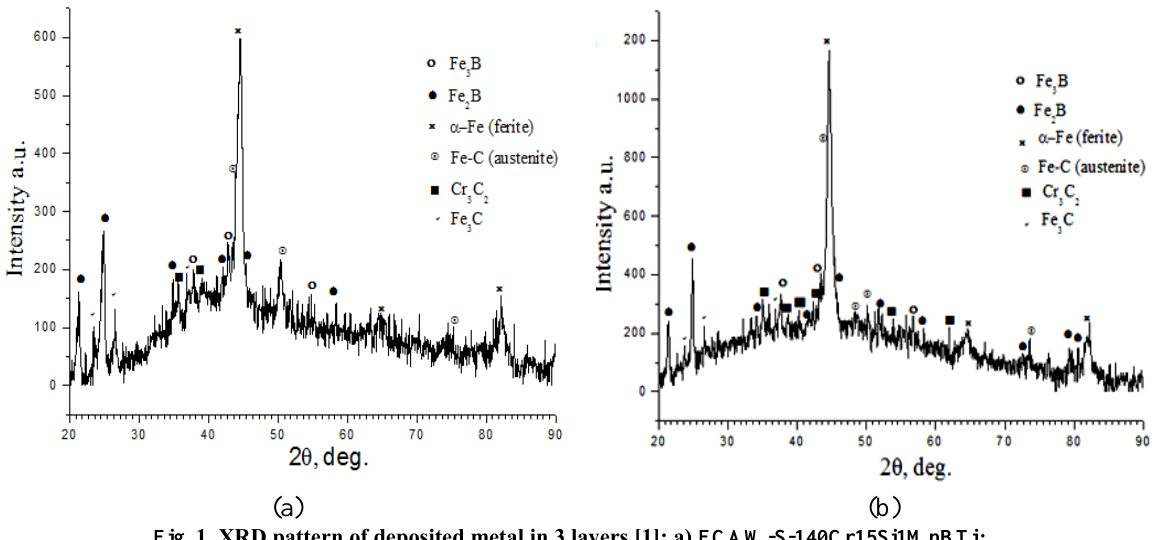
Fig. 1. XRD pattern of deposited metal in 3 layers [1]: а) FCAW-S-140Cr15Si1MnBTi; b) FCAW-S-110Cr4Cu5TiVBAl with exothermic addition CuO - Al.